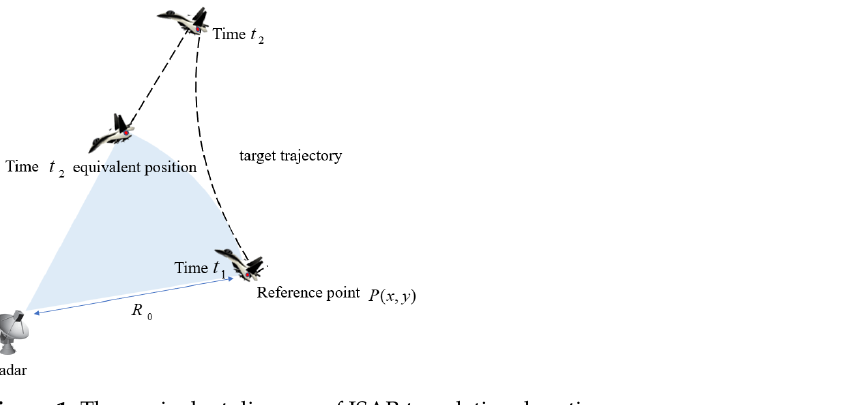
Figure 1. The equivalent diagram of ISAR translational motion.